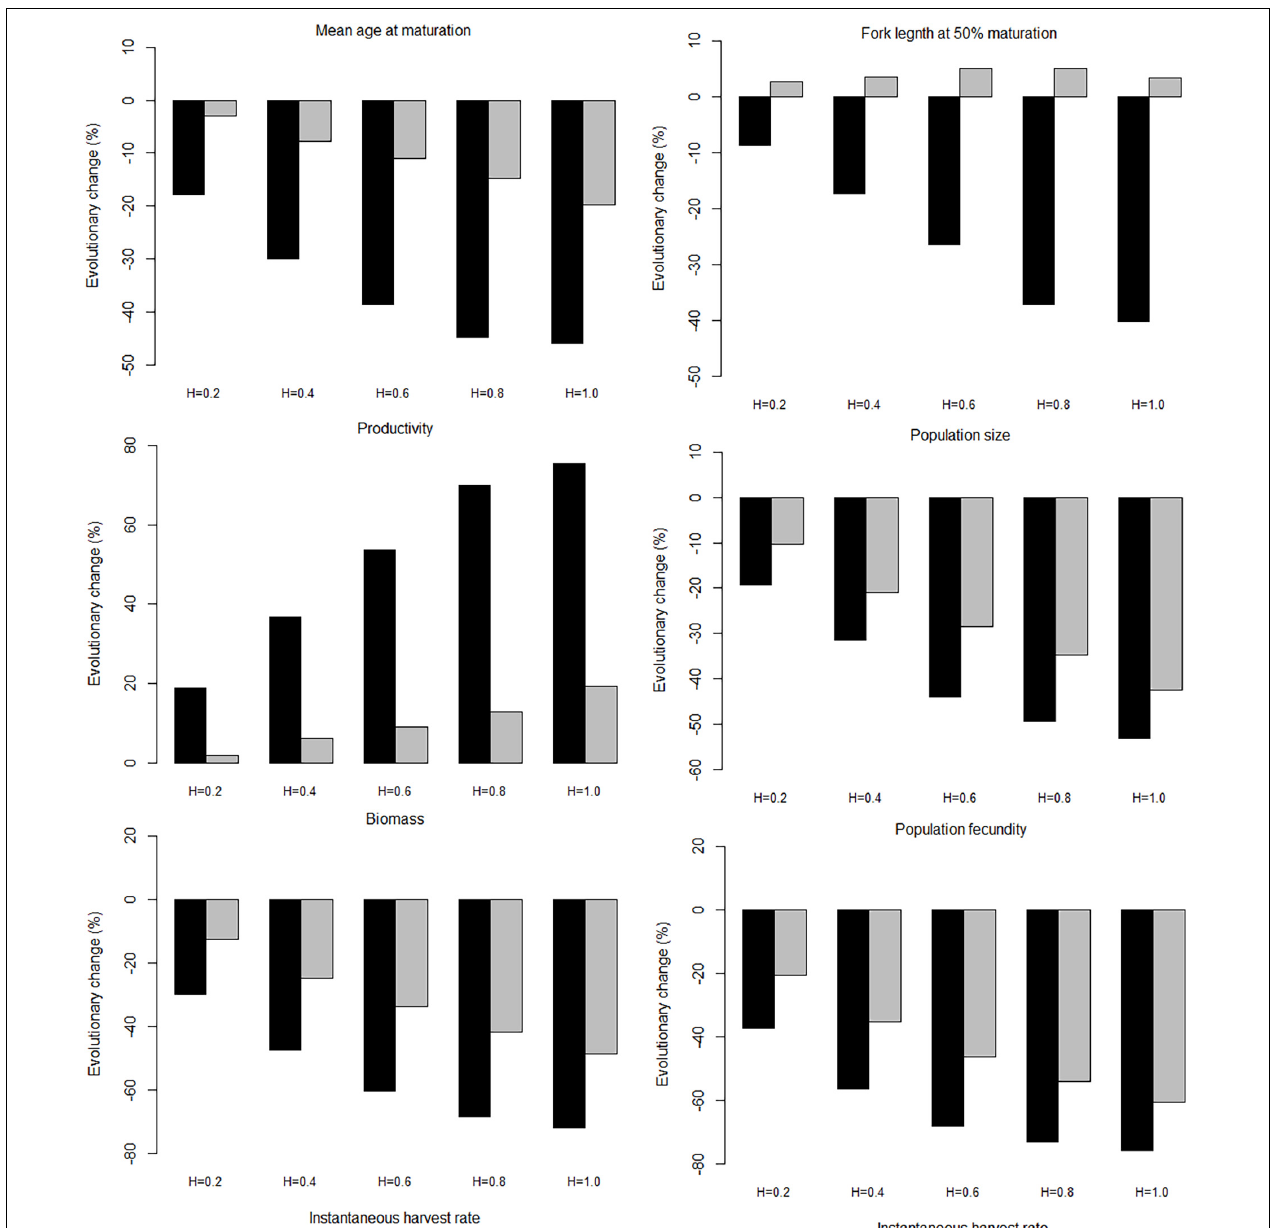
FIGURE 9 | Effect of the maximum instantaneous harvest rate on the mean value of population traits. Panels show the percentage change after 100 years of harvesting, relative to the 100 years before harvesting started. The black bars, trawl-harvested scenarios; the gray bars, gillnet-harvested